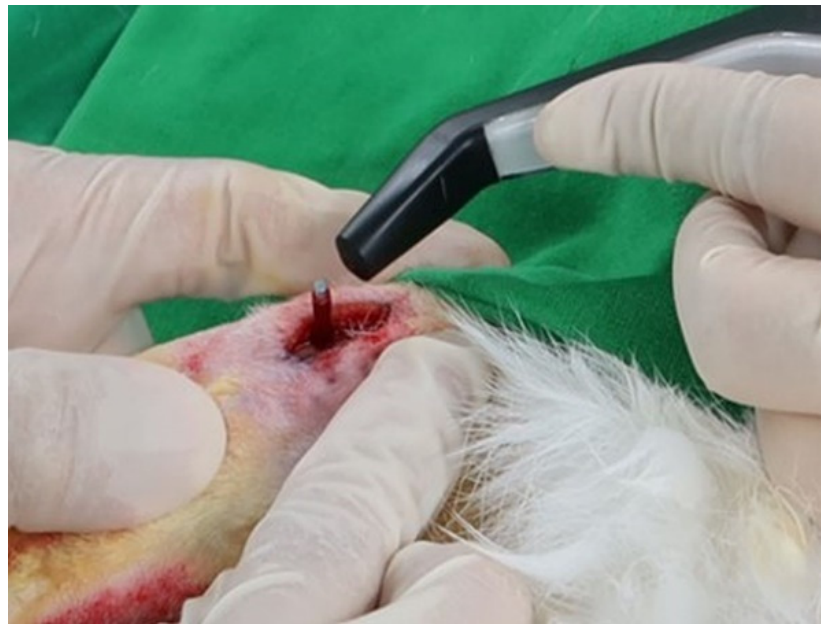
Figure 4. Measurement of the implant stability quotient immediately after surgery.